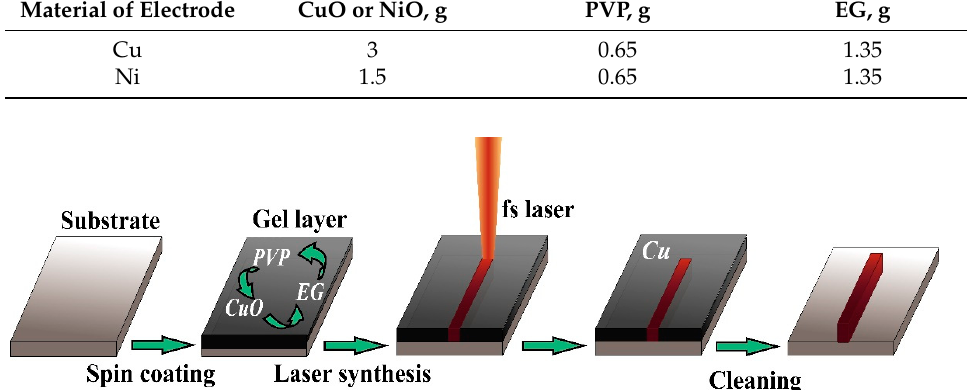
Table 1. The optimized compositions for deposition of Cu and Ni micropatterns on glass-ceramic. Material of Electrode